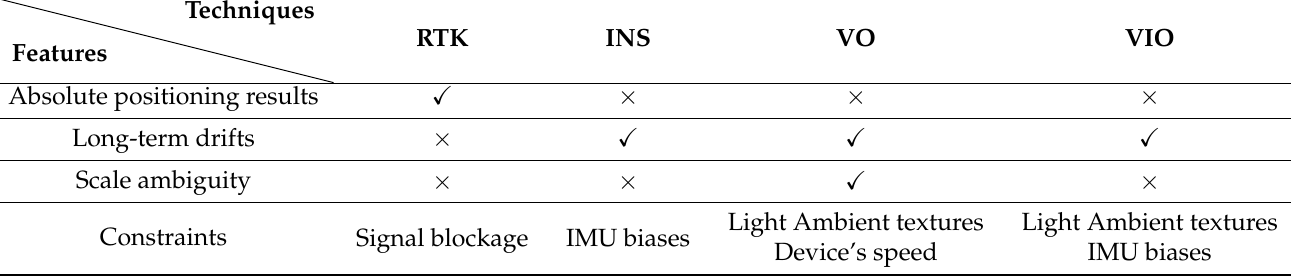
Table 1. The comparison of different positioning techniques.